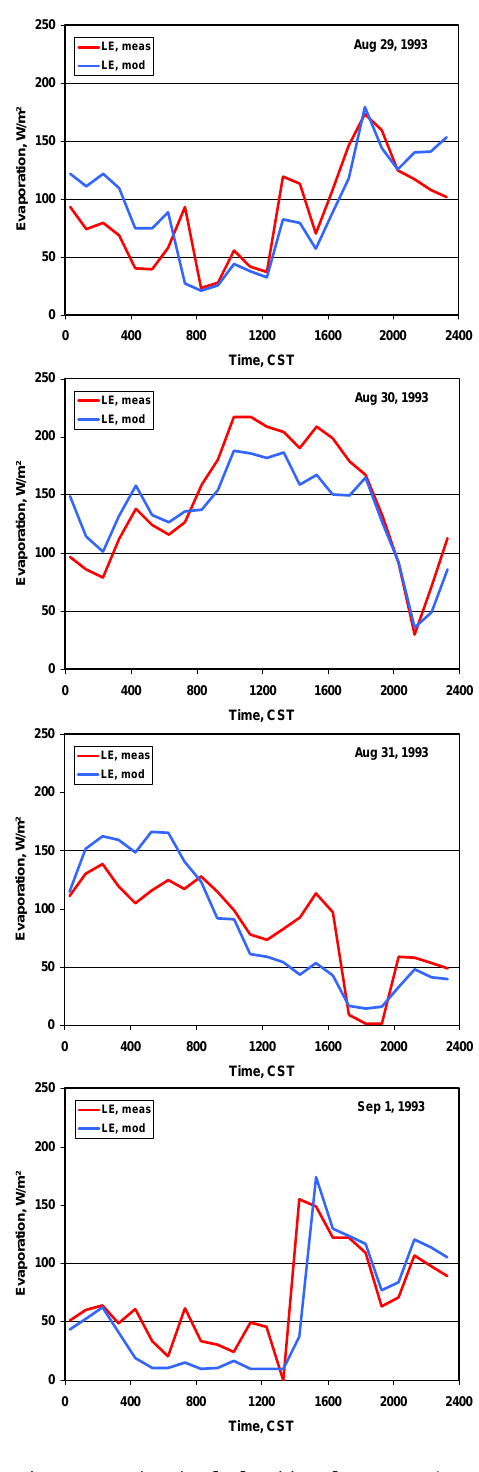
Fig. 9. The measured and calculated hourly evaporation rates for Figure 9. The measured and calculated hourly evaporation rates for 4 consecutive days on 4 consecutive days on Quill Lake (29 August–1 September Quill Lake (Aug. 29 – Sep.1, 1993).